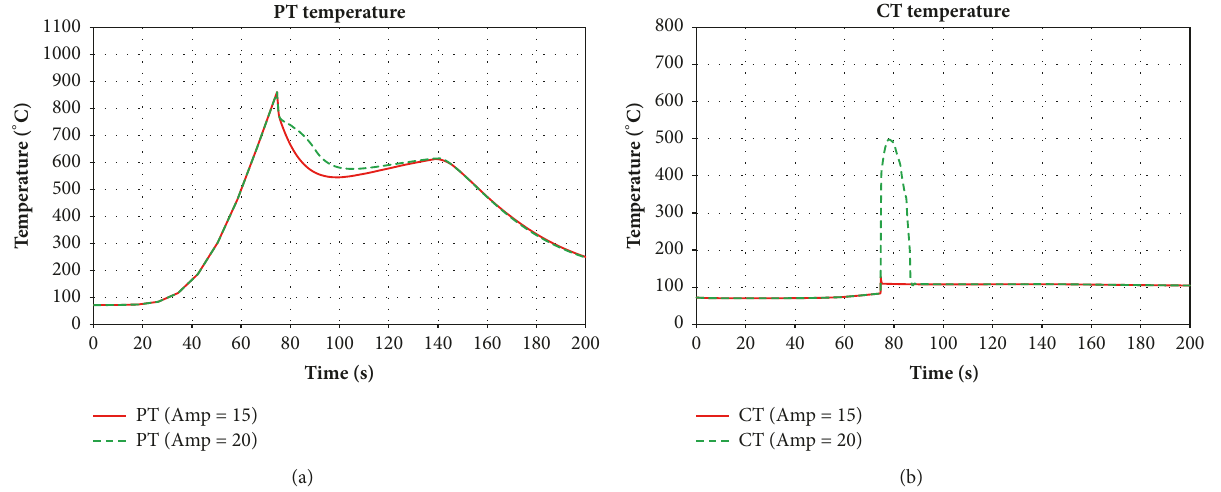
Figure 8: Dependency on the amplification factor of thermal conductivity gradient for 0.1 seconds of contact at (a) the inner surface of PT and (b) the outer surface of